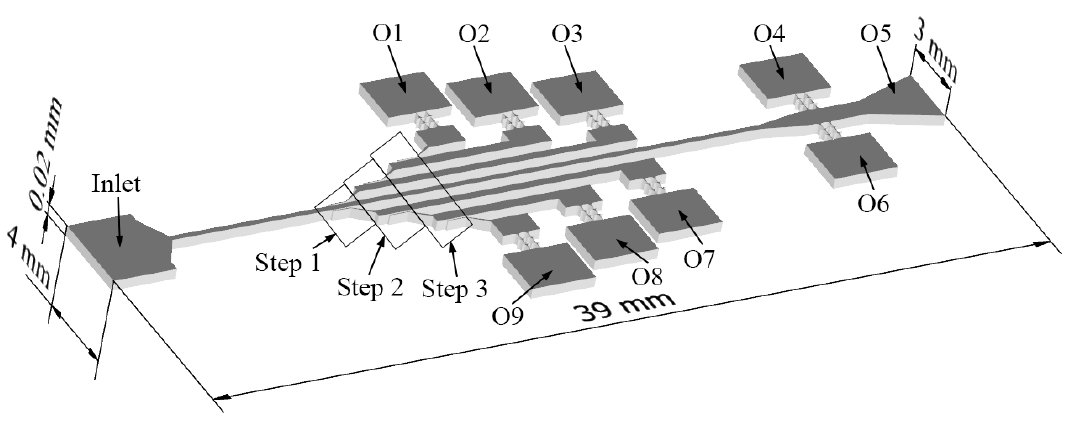
Figure 1. Schematic diagram of the geometry and dimensions of the tested multi-step crossflow microfluidic device. The device has one inlet and nine outlets (O1 to O9). At approximately ¼ of its length, the main channel connects with the lateral channels on both sides through ramifications with a row of pillars (steps). Hyperbolic constrictions are present before each outlet, with the exception of outlet 5. The main channel has a width of 0.5 mm and the side channels have a width of 0.4 mm after the first separation step and 0.5 mm after the following step. Table 1. Main dimensions of the multi-step crossflow microfluidic device.